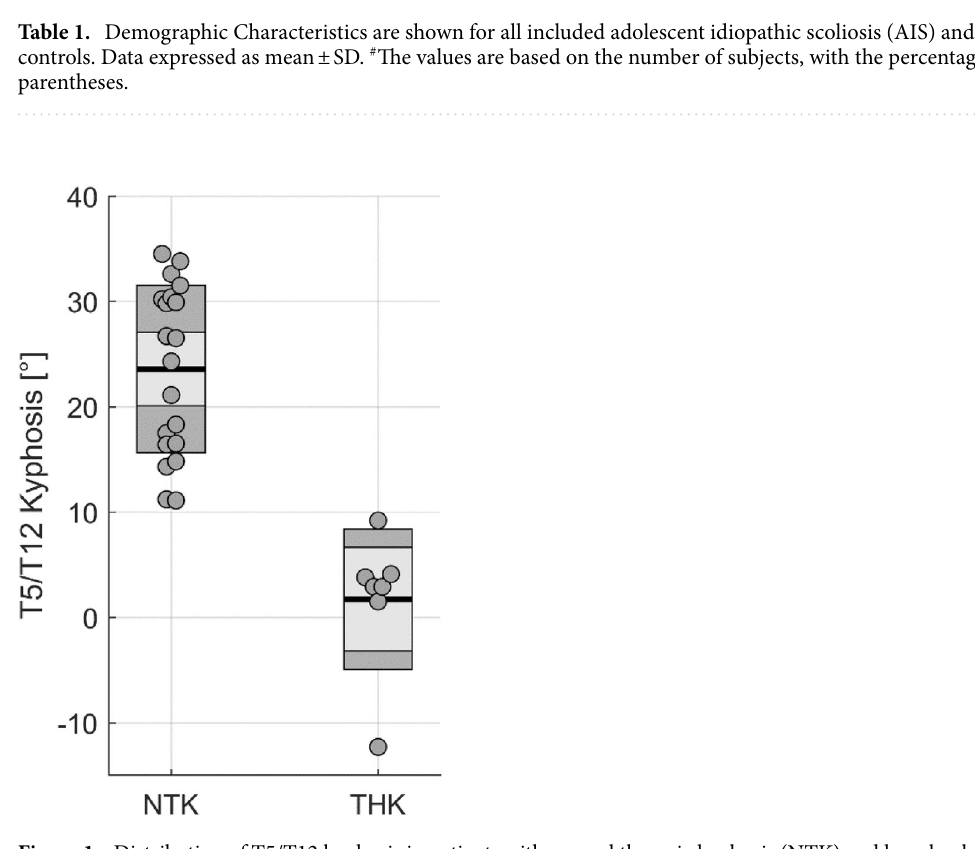
Figure 1. Distribution of T5/T12 kyphosis in patients with normal thoracic kyphosis (NTK) and hypokyphosis